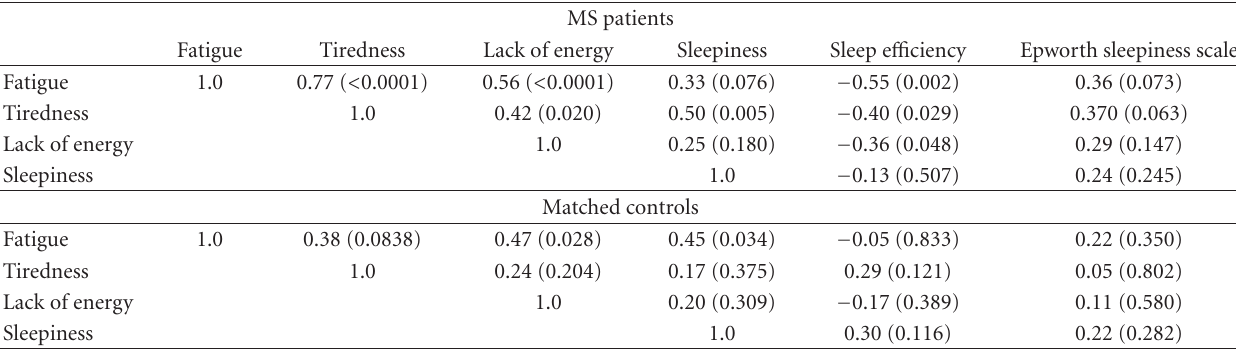
Table 2: Spearman correlation test results for University of Michigan Sleepiness Impact Assessment responses and polysomnographic para- meters in MS patients (top) and matched controls (bottom). Values listed as Spearman coe ffi cient ( P